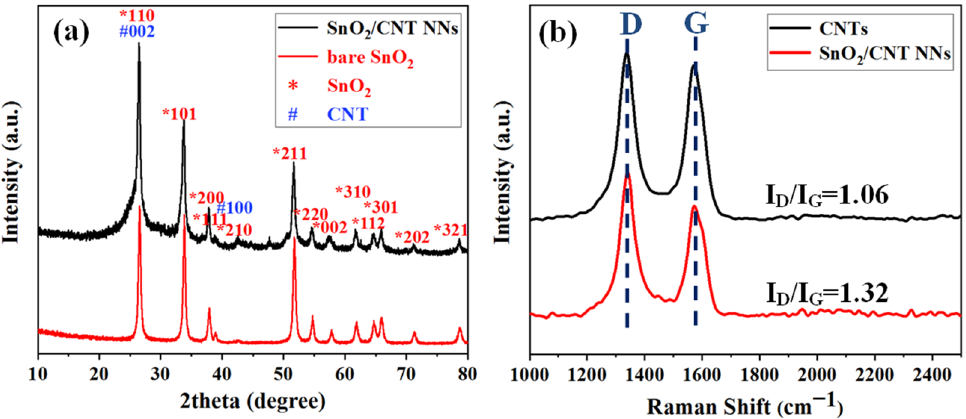
Figure 3. ( a ) XRD patterns of bare SnO 2 , SnO 2 /CNT NNs composites and ( b ) Raman spectra of pristine CNTs, SnO 2 /CNT NNs composites.